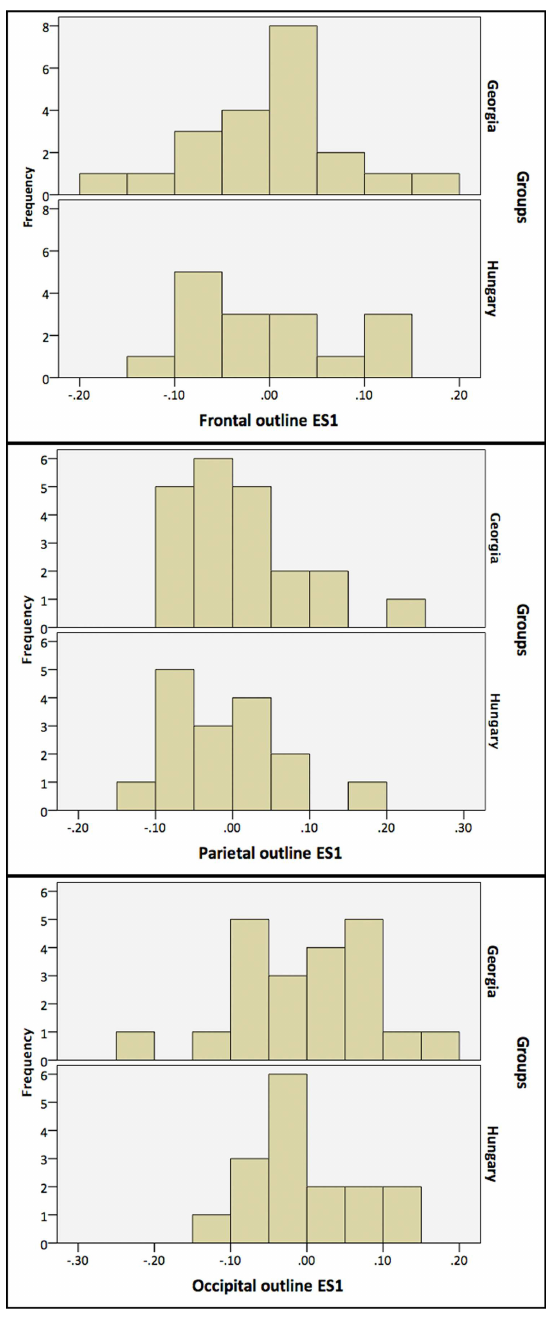
Fig 13. Histogram depicting the frequency of eigenscores on ES1 for the Georgian and Hungarian crania on frontal, parietal and occipital